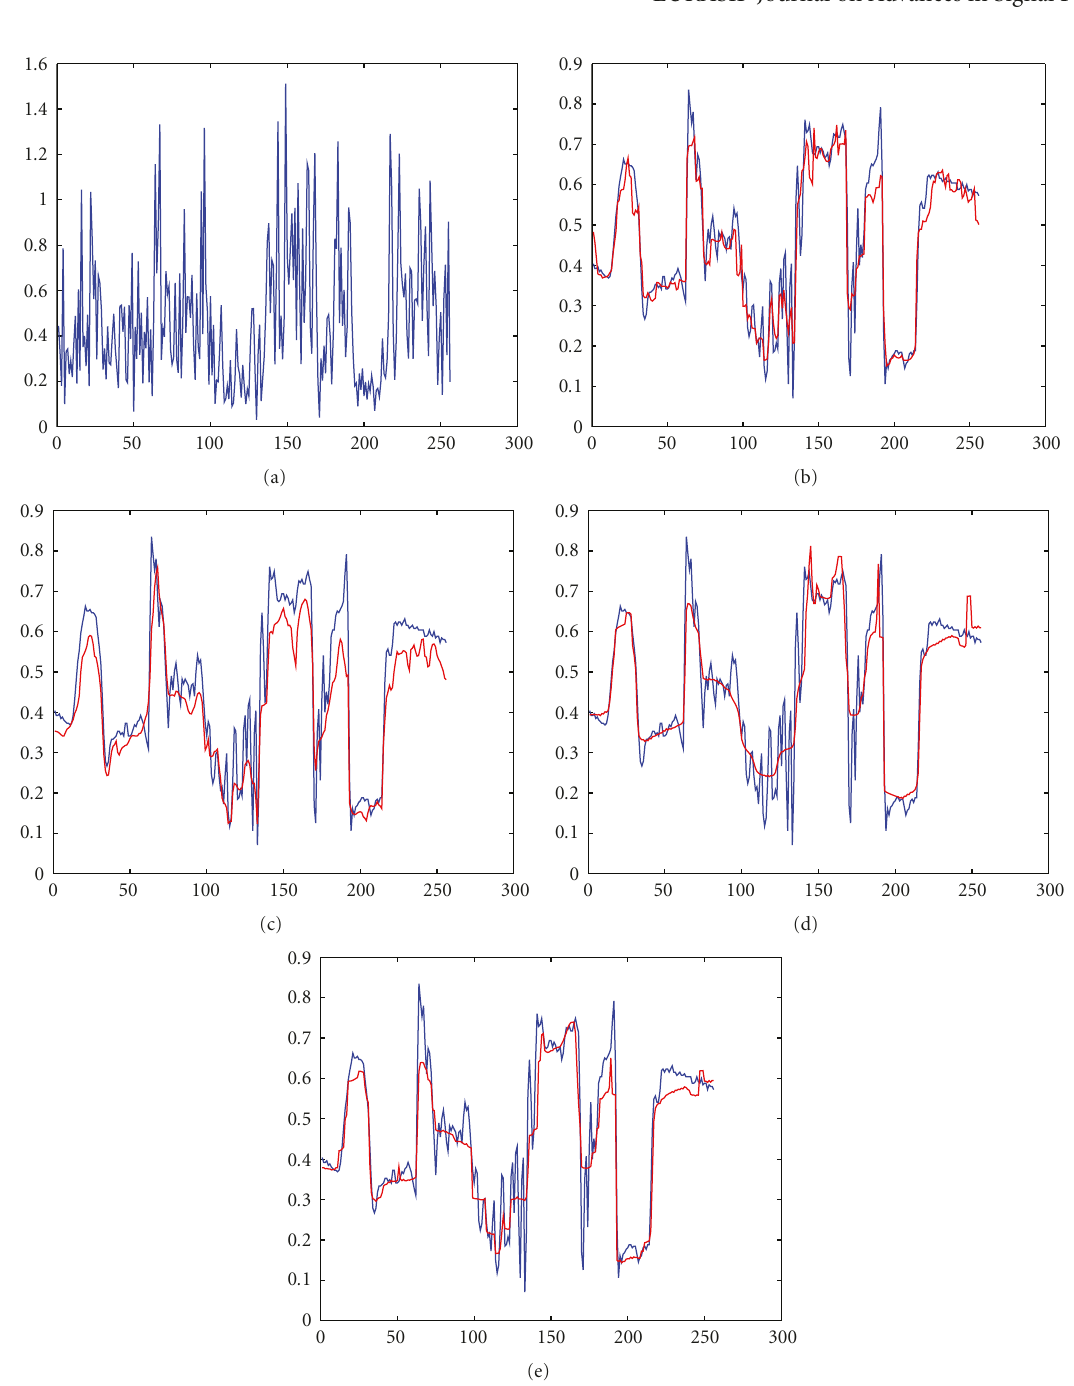
Figure 9: The 100th line of the original, noisy, and restored images for denoising Figure 2(b). (a) The noisy image; (b) the slice restored by the proposed method; (c) the slice restored by the “HMW” method; (d) the slice restored by the “AA” method; (e) the slice restored by the “RLO” method. Here the blue line is the original image, and the red line is the restored